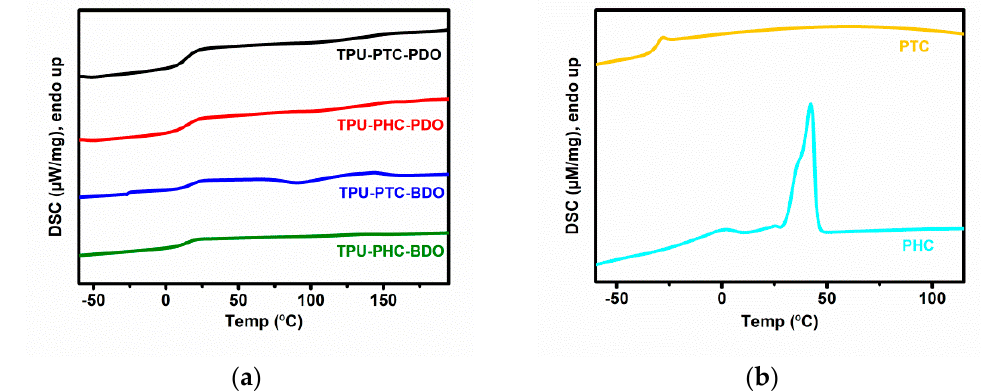
Figure 7. Second heating DSC thermograms of ( a ) TPU and ( b ) polyols.